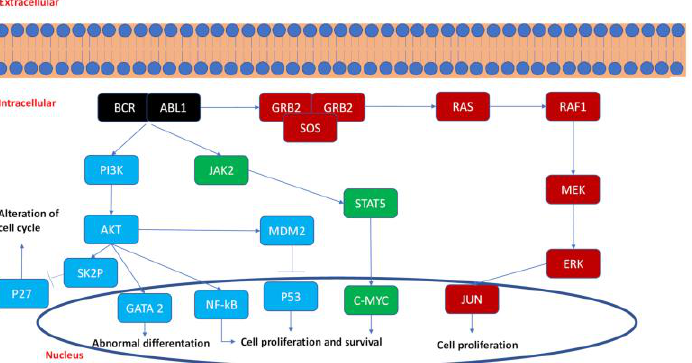
Figure 1. BCR-ABL1 signaling pathway.